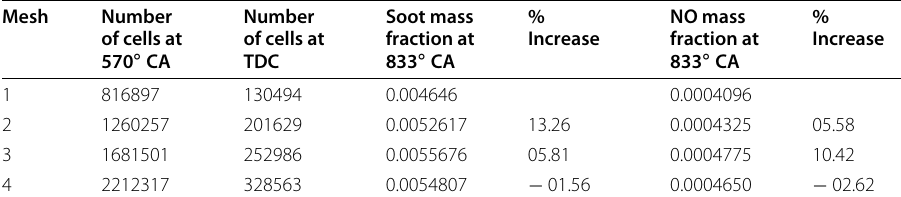
Table 2 Mesh independence study